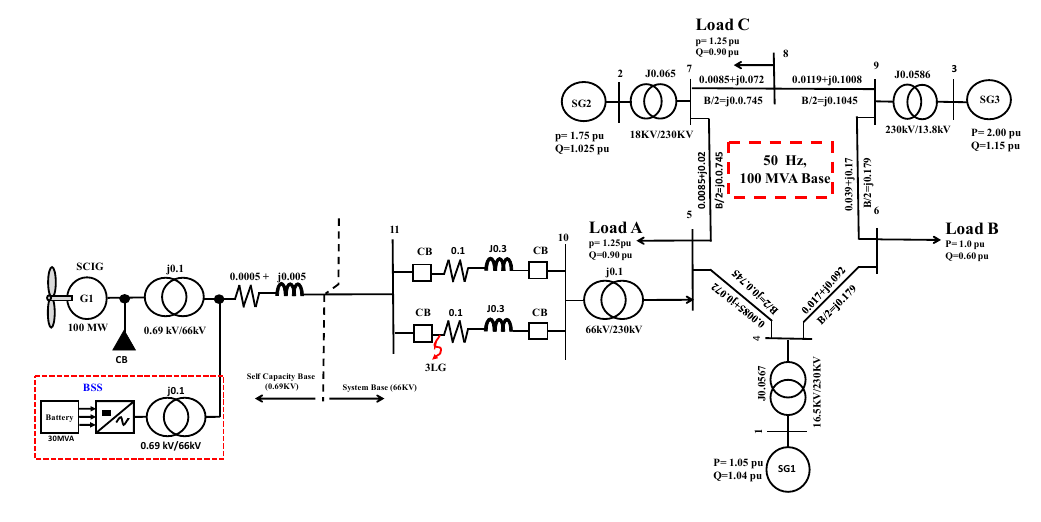
Figure 1. Model of hybrid power system.